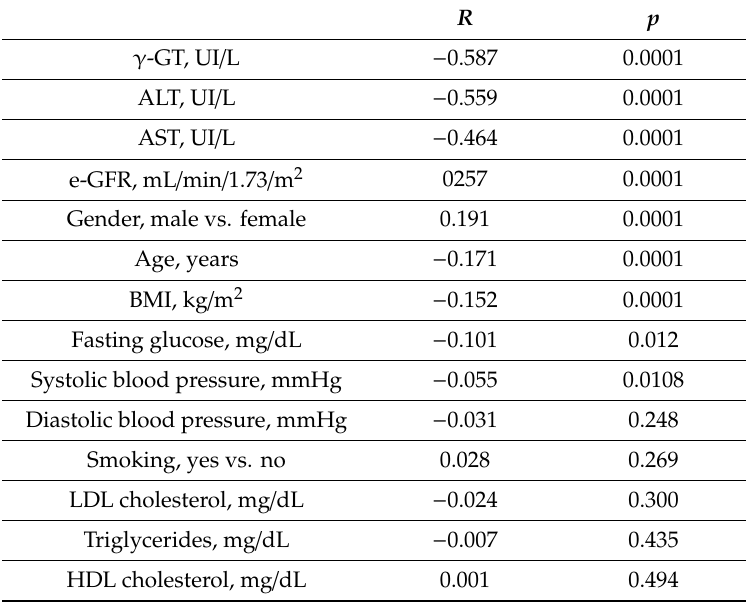
Table 2. Univariate relationships between FBF maximal response to acetylcholine and different covariates.